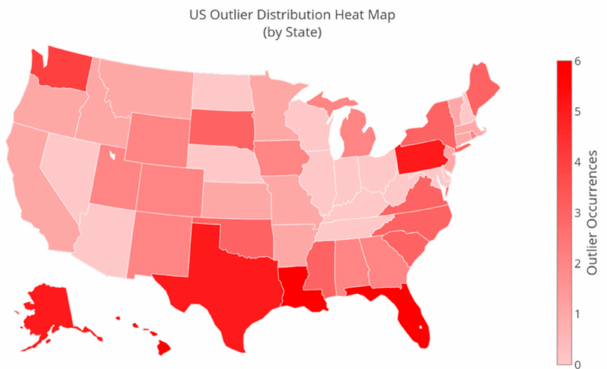
Figure 14. The distribution heat map of detected abnormal users referring to each